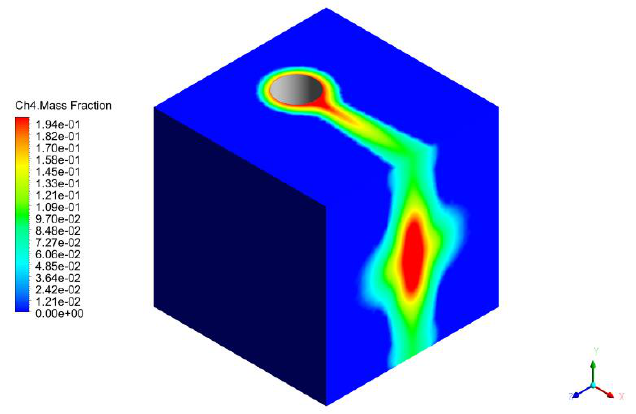
Figure 8. CH 4 m.f. contour plot on the SB faces.